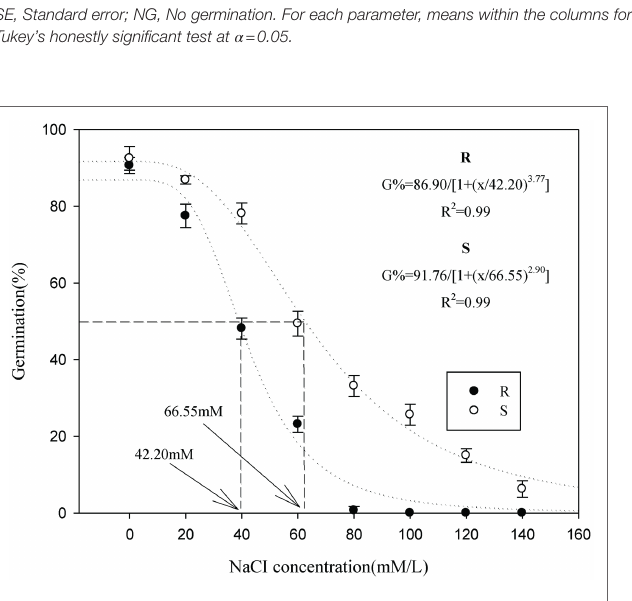
FIGURE 1 | Effect of salt stress on the germination of the different Polypogon fugax populations. Error bars represent standard error of the means. Values represent the mean of eight replications with 40 seeds per replication. The abbreviations R and S represent for the resistant and sensitive P. fugax populations,